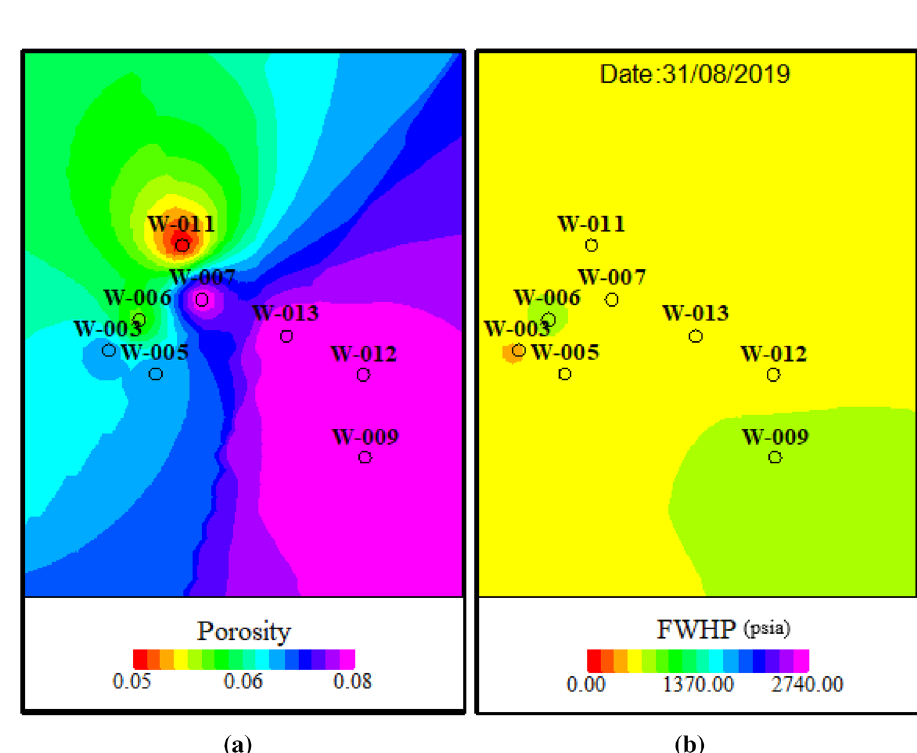
Fig. 8 a Grid map of wells initial porosities, b grid map of wellhead pressure at a certain